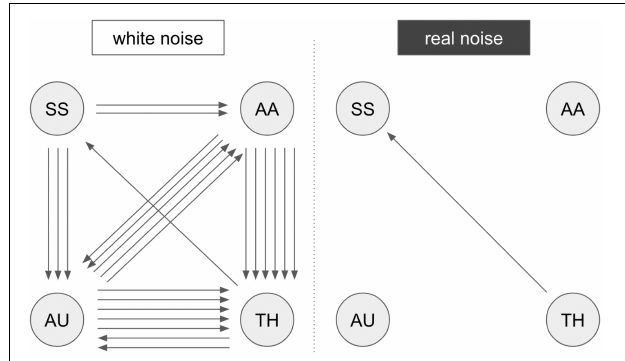
FIGURE 3 | Results of the GCA analysis. Summarized results of the Granger causality analysis of fMRI Experiment 2 with pairwise comparison “white noise > real noise” (white noise) and “real noise > white noise” (real noise). The arrows represent significant connections in the comparison matrix ( Supplementary Figure 1 ). An arrow represents a registered causal link (compare Supplementary Figure 1 ). SS, somatosensory areas; AU, auditory areas; AA, postparietal association cortex; TH, thalamus. A more detailed description of the brain regions is provided in Supplementary Table 1